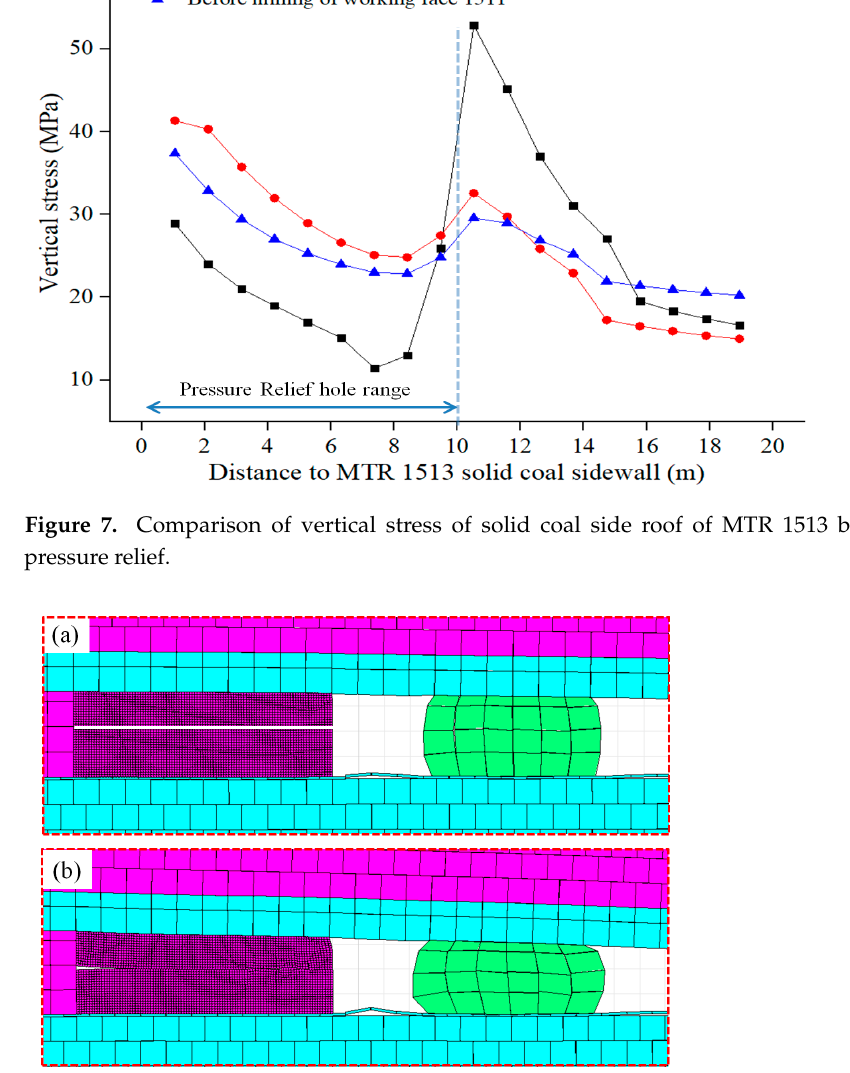
Figure 8. Deformation of the pressure relief hole before and after mining in working face 1511. (a) before the mining of working face 1511; (b) after the mining of working face 1511.